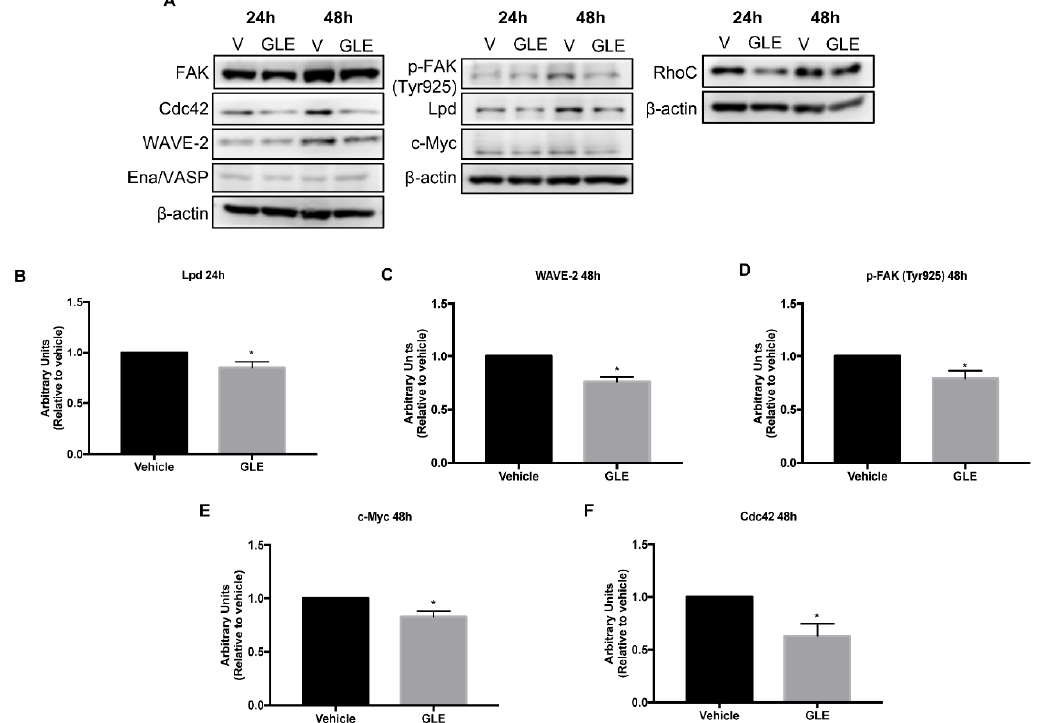
Figure 4. GLE modulates the expression of proteins involved in cell migration in MDA-MB-231 breast cancer cells. ( A ) MDA-MB-231 cells were grown in 5% FBS media for 24 h prior to treatment with vehicle (0.1% DMSO) or GLE (0.96 mg/mL, 0.50 mg/mL) for 24 and 48 h, respectively, before lysis. Equal amount of protein (30 µg) from each sample was used for western blot analysis. β -actin was used as a loading control. ( B – F ) Densitometry analysis of Western blot bands. Data are expressed as mean ± SEM. Experiments represent data obtained from three independent biological replicates. Statistically significant di ff erence is shown at * p < 0.05 compared to